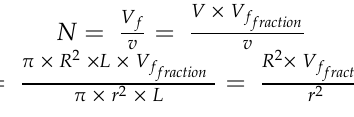
nano-CT scanner ( d ).